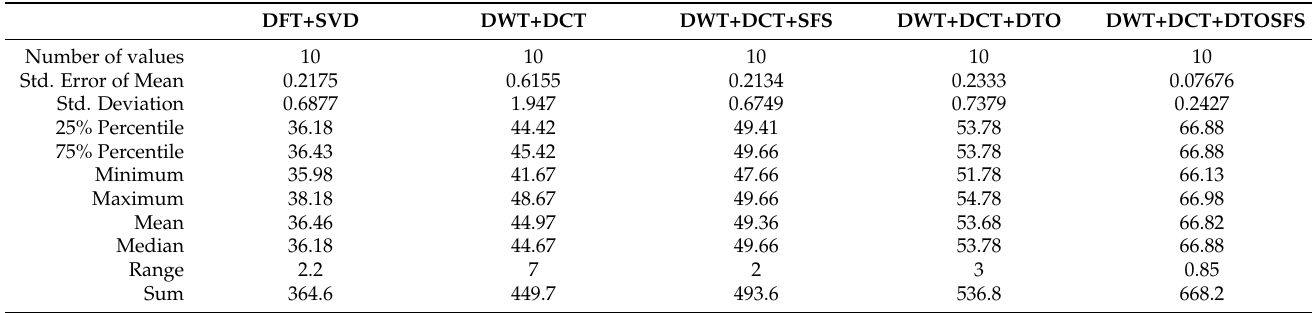
Table 2. Statistical analysis of the proposed approach compared to other approaches.